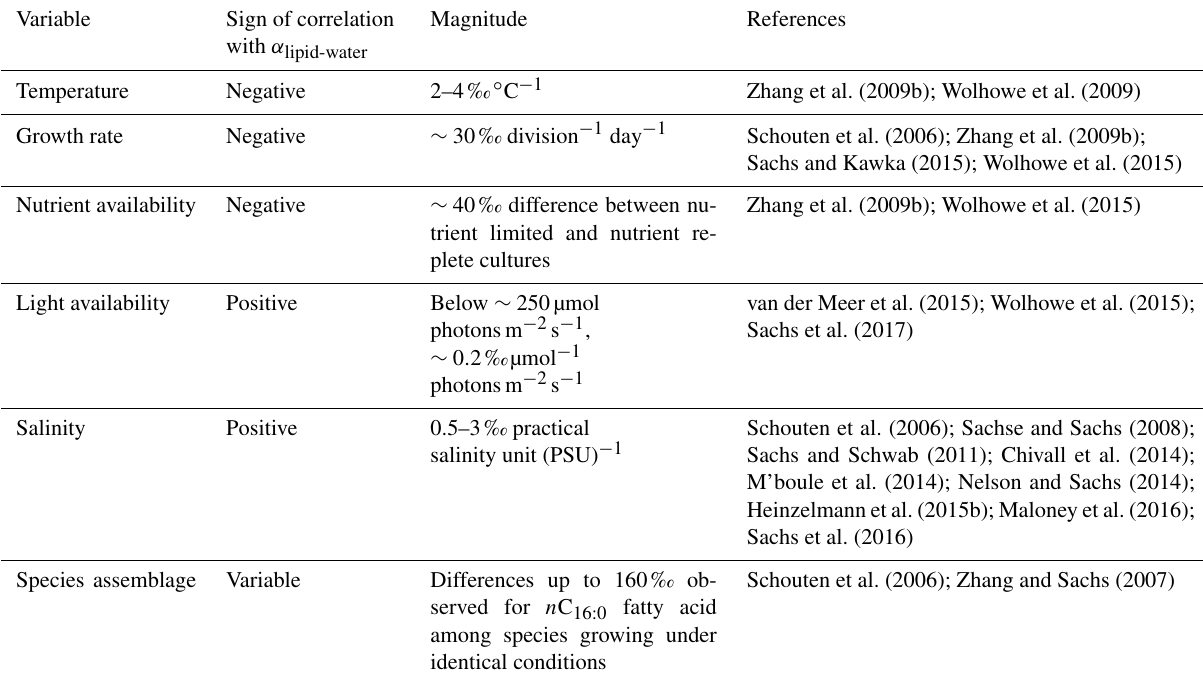
Table 1. Summary of expected changes in α lipid-water in response to different environmental variables, based on laboratory cultures and field studies in marine